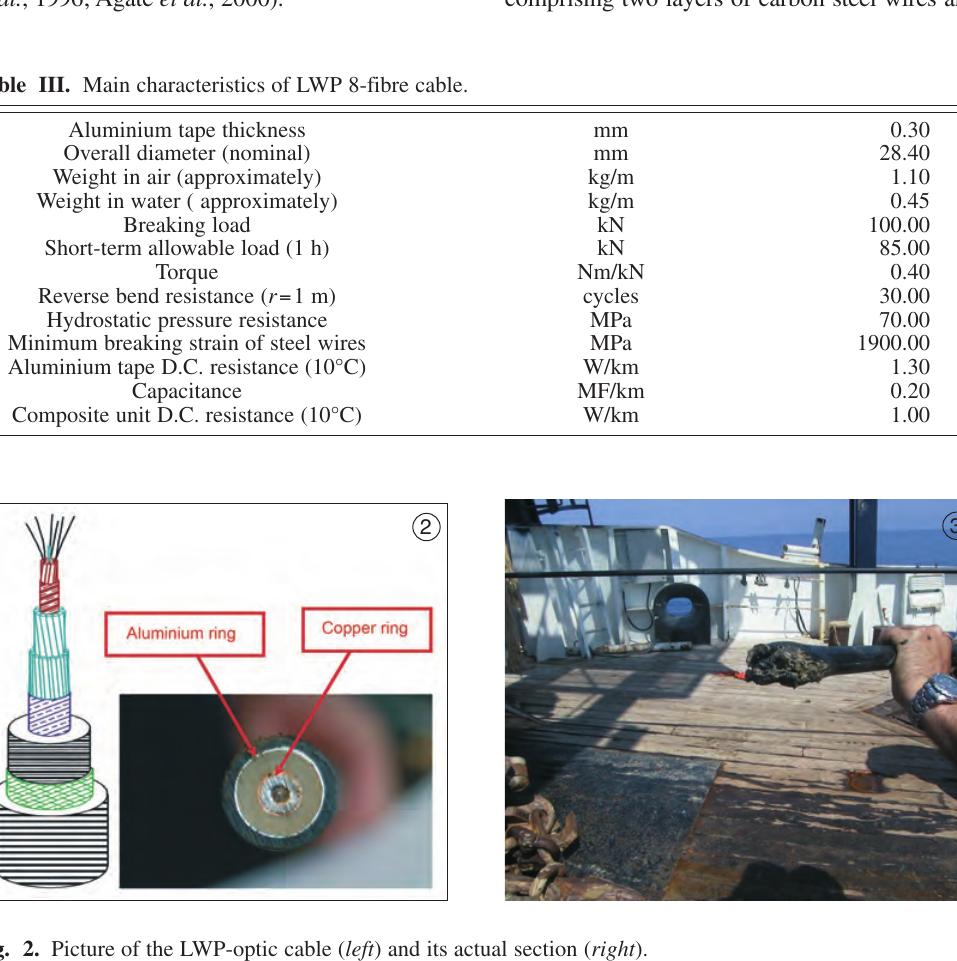
Fig. 2. Picture of the LWP-optic cable ( left ) and its actual section ( right ). Fig. 3. Photograph of the end of the burnt fibre-optic cable taken on board the cable ship just after the recovery.